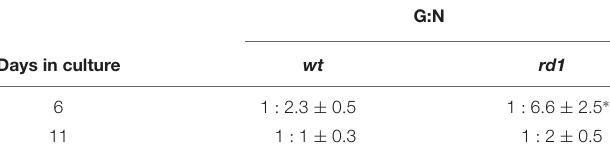
TABLE 2 | MGC: neuron ratio.